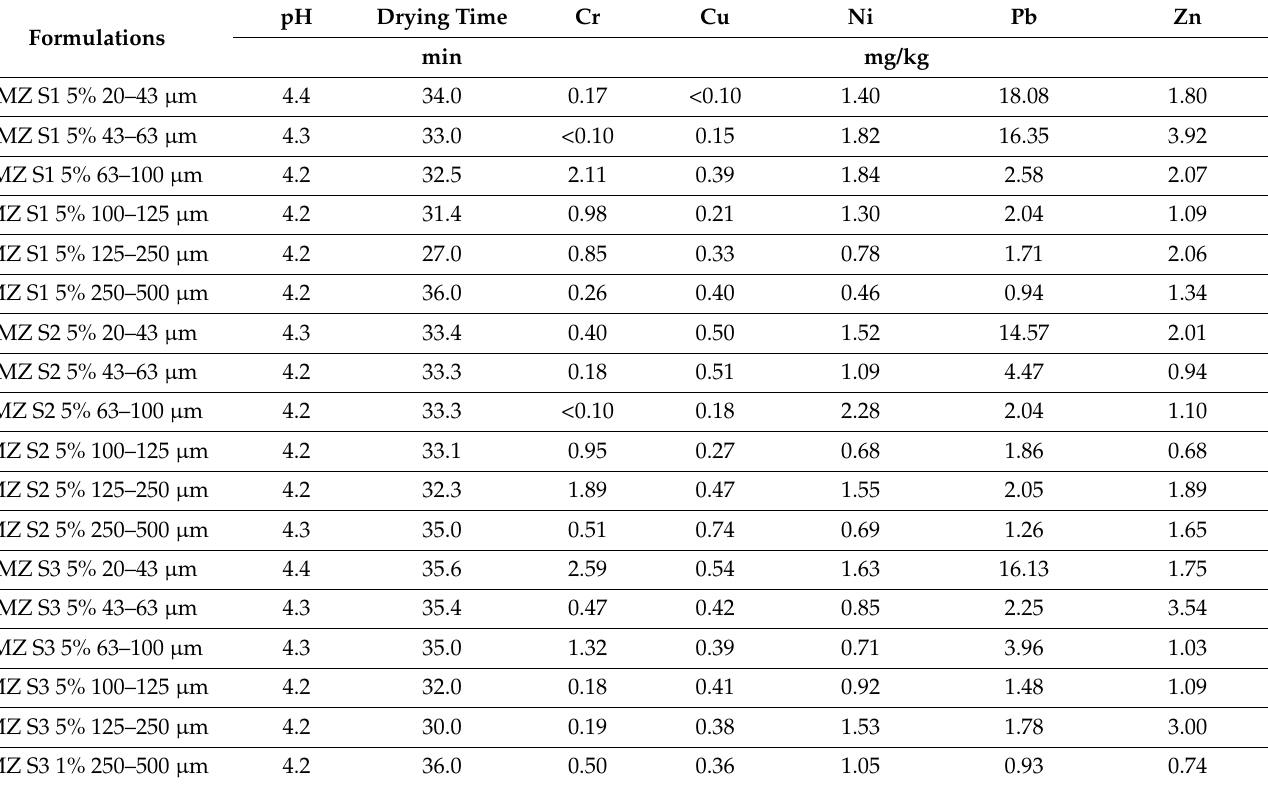
Table 4. pH, drying time and trace element concentrations of cosmetic formulations containing 5% MZ of different particle